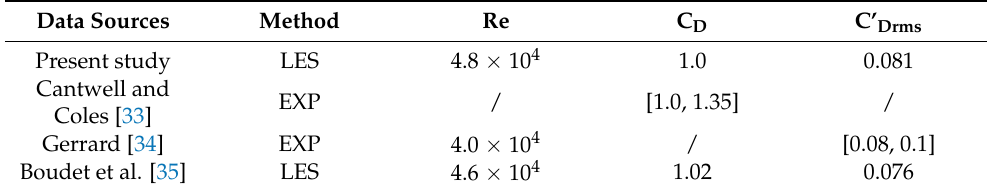
Table 1. Computed forces in comparison with the available experimental data.